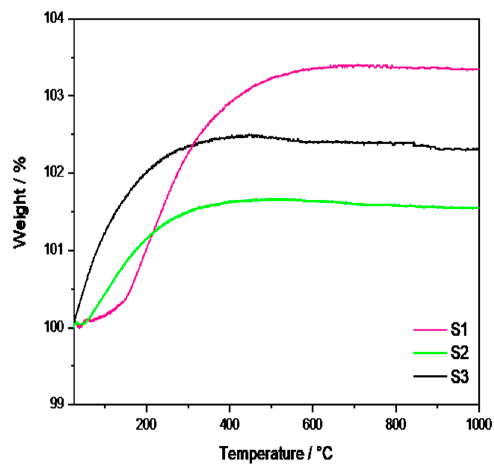
Figure 2. TGA of the synthesized CTFO powders.